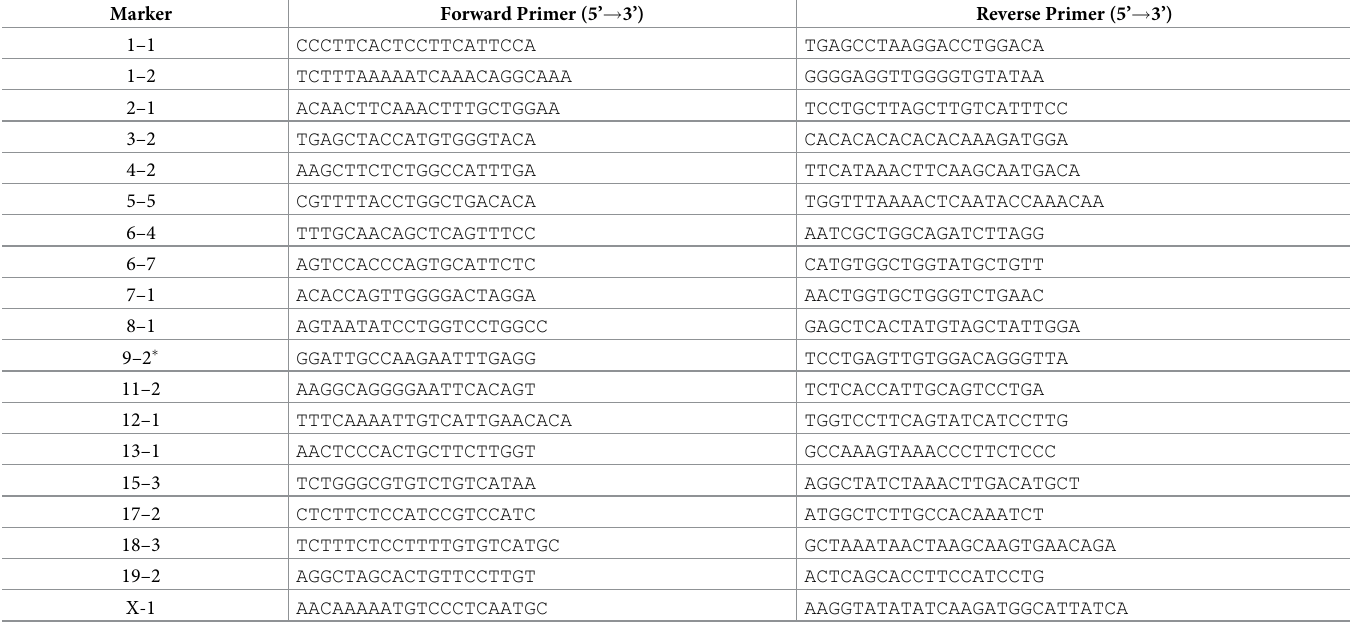
Table 1. Primers used in the mouse multiplex PCR